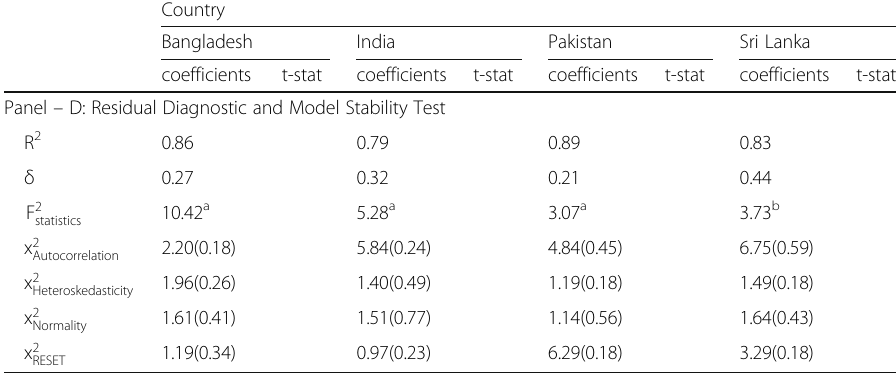
Table 5 Non-linear ARDL estimation results (Continued) Country